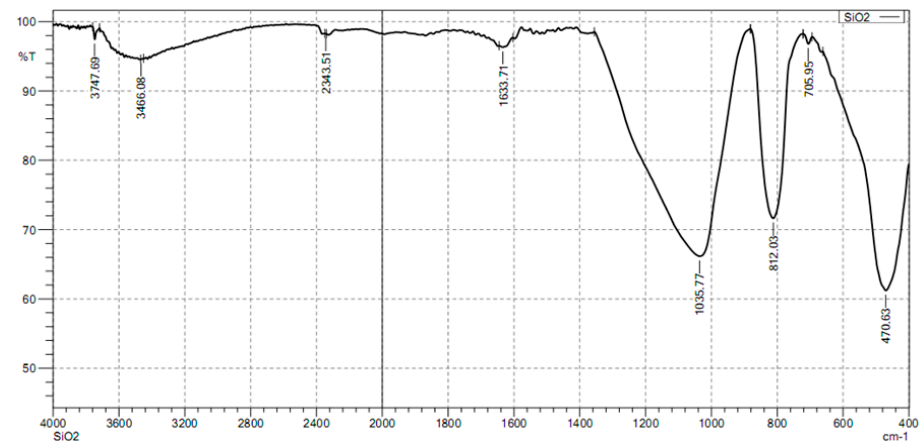
Figure 4. FTIR spectrum of nanosilica particles in the wave number range 400–4000 cm − 1 .